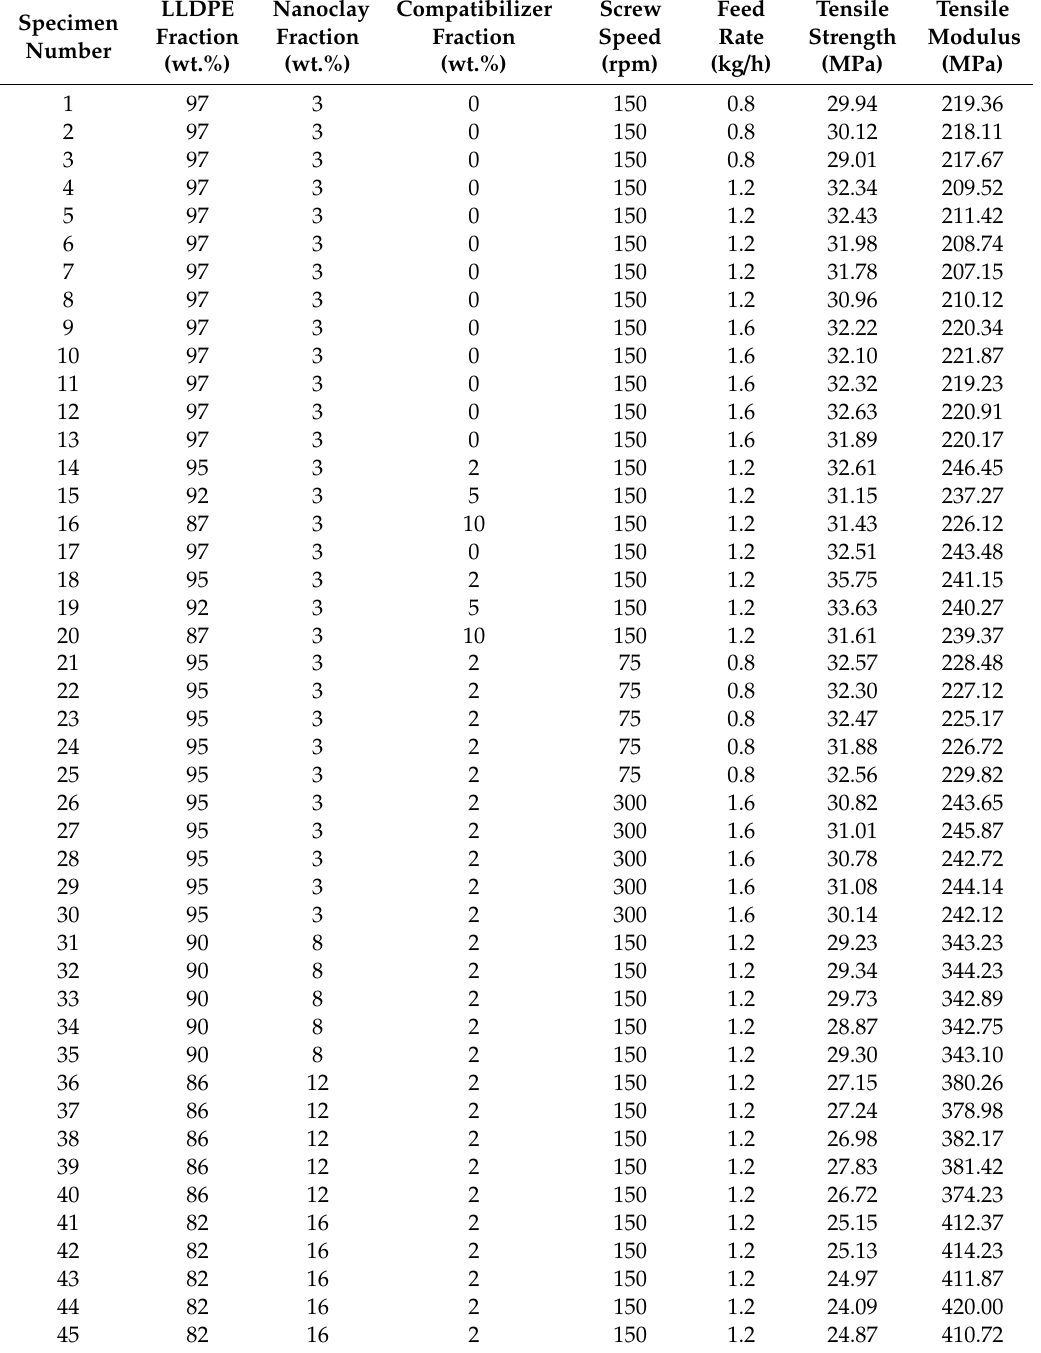
Table 1. Experimental data for di ff erent processing